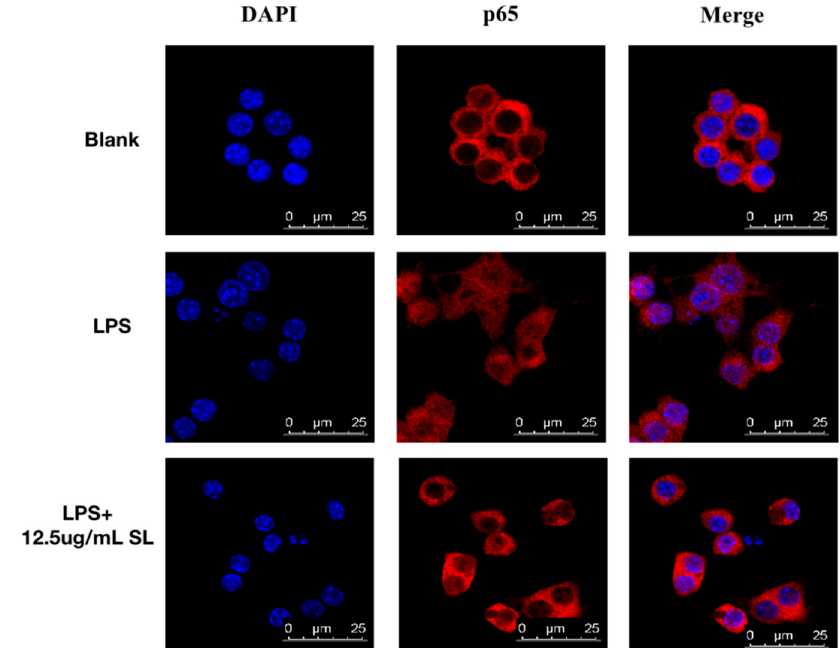
Figure 6. Effect of SL on nuclear translocation of NF- κ B p65 in LPS-induced RAW 264.7 cells. Localization of NF- κ B p65 (red) was visualized using confocal microscopy after immunofluorescent staining. Nuclei were stained with DAPI (blue). Results are representative of those obtained from three independent tests.